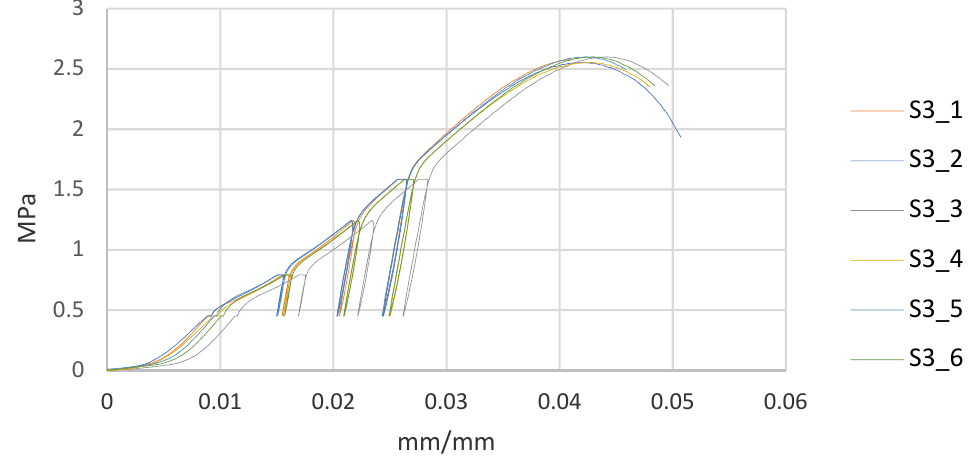
Figure 8. Stress–deformation plot relating to S3_1–S3_6 cylindrical samples subject to an unconfined compression test.